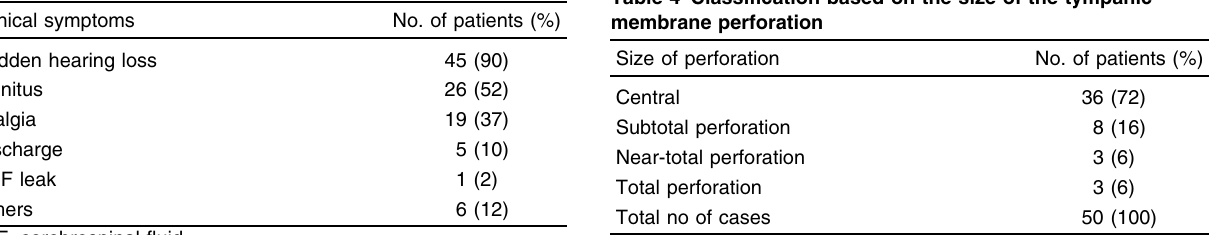
Table 3 Clinical presentation